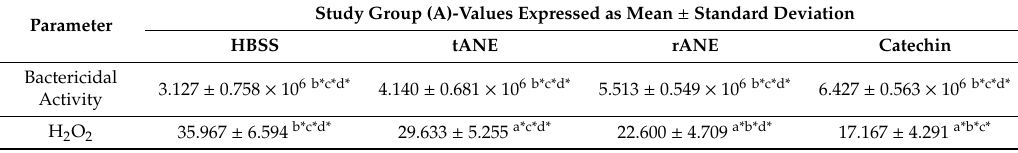
Table 3. Post-hoc analysis of microbiological (bactericidal activity) and biochemical (hydrogen peroxide) parameters for group (A)—healthy